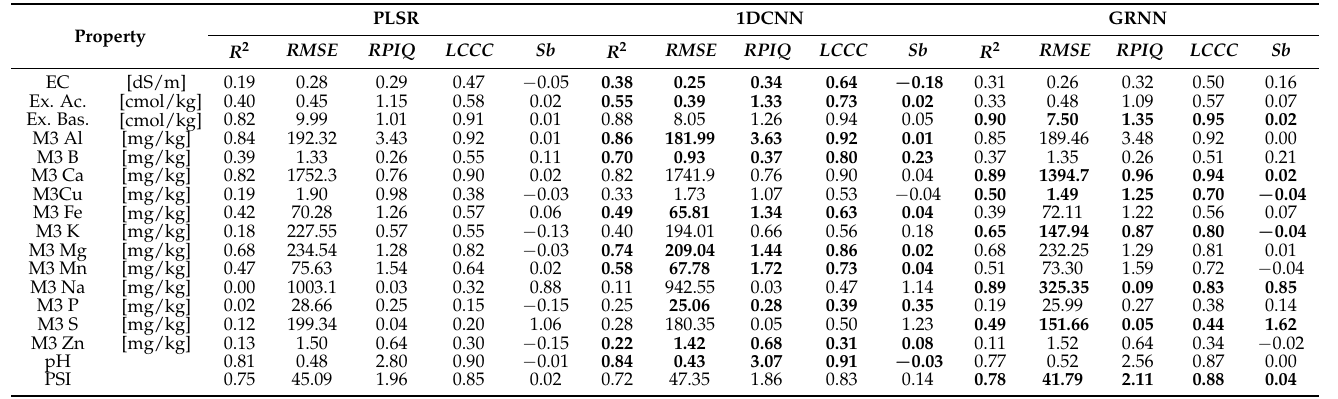
Table 5. Summary of model validation statistics for the “Mehlich” group. The best prediction result for particular variables is marked in